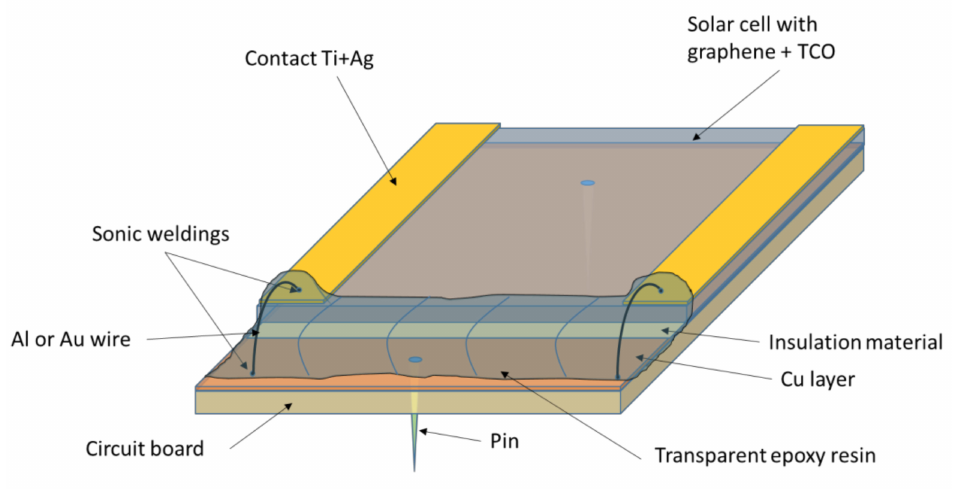
Figure 3. Sketch of a solar cell with a hybrid graphene / transparent conductive oxides (TCO)-based transparent contact and Au or Al micro-wires sonic